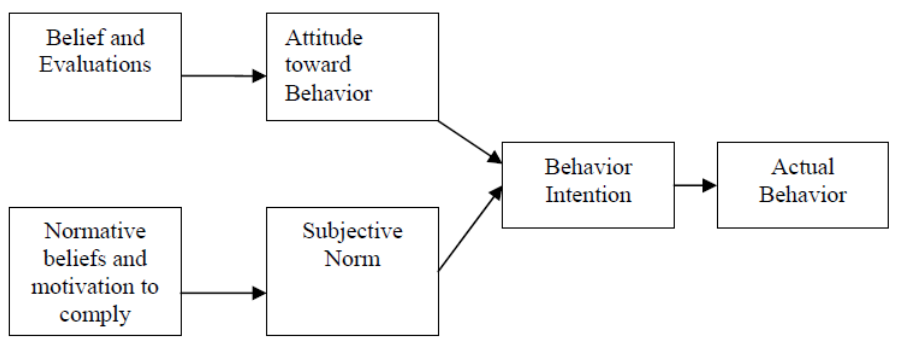
Figure 1 The theory of reasoned action (Fishbein & Ajzen, 1975)